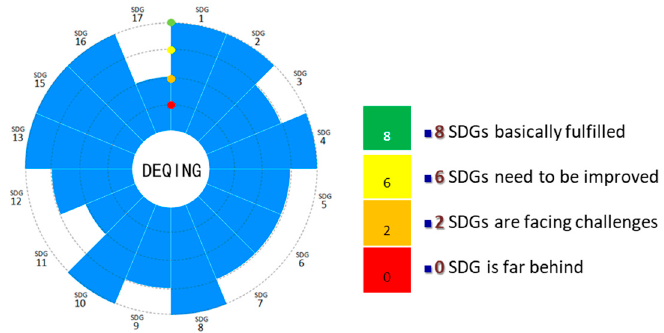
Figure 7. Assessment result of all the 16 individual SDGs in Deqing.